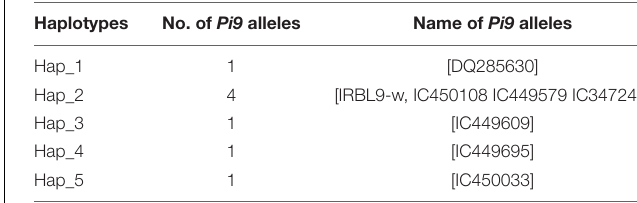
TABLE 3 | List of identified